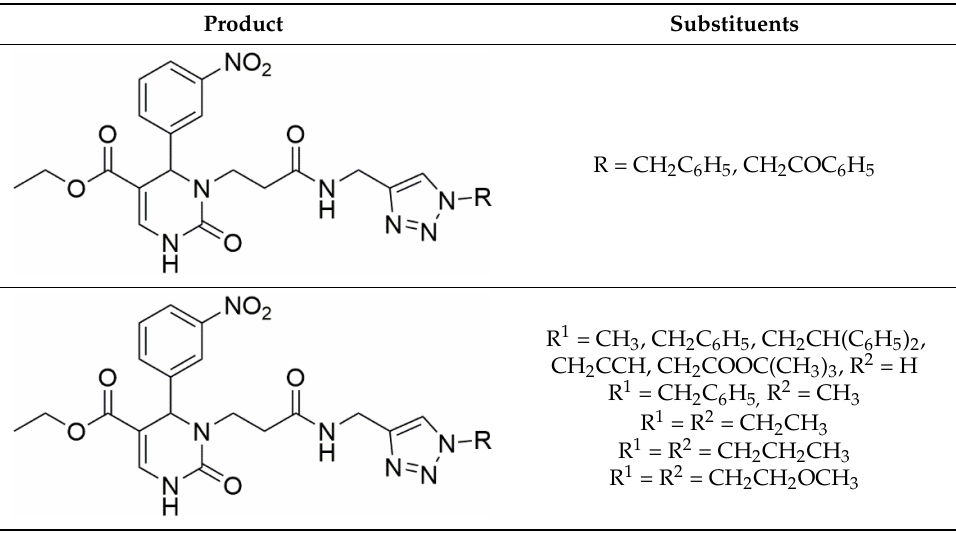
Table 2. Triazole ligation introducing nitrile, carboxylic, and hydrazide groups. Amino acid coupling reactions were conducted to obtain the compounds listed in the